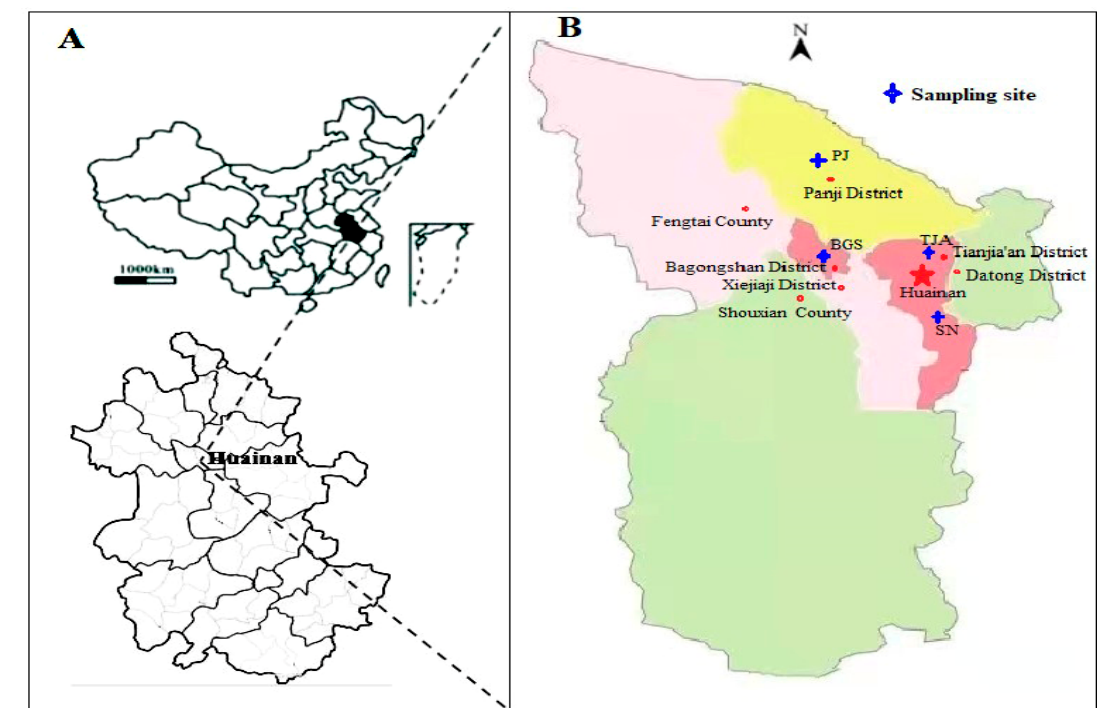
Figure 1. Sampling sites of municipal sewage treatment plants in Huainan.